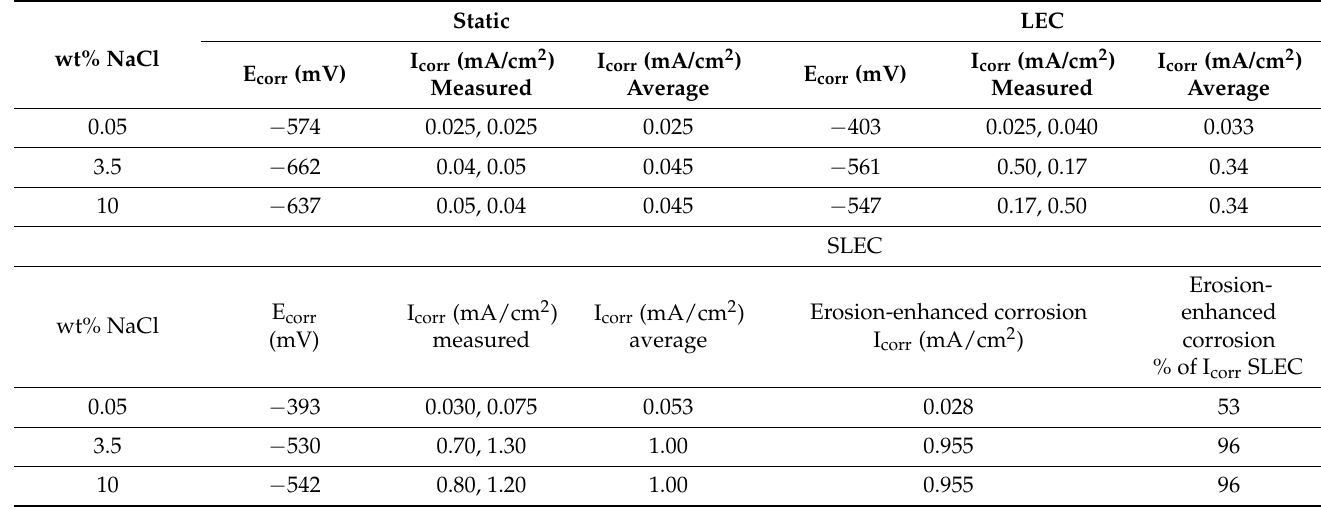
Table 6. Corrosion rates of UNS G43400 low-alloy steel in the different hydrodynamic